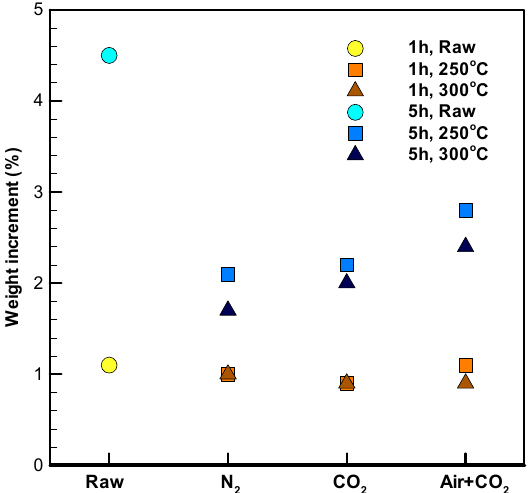
Figure 10. Profiles of weight increment or raw and torrefied corncob wastes from hygroscopicity